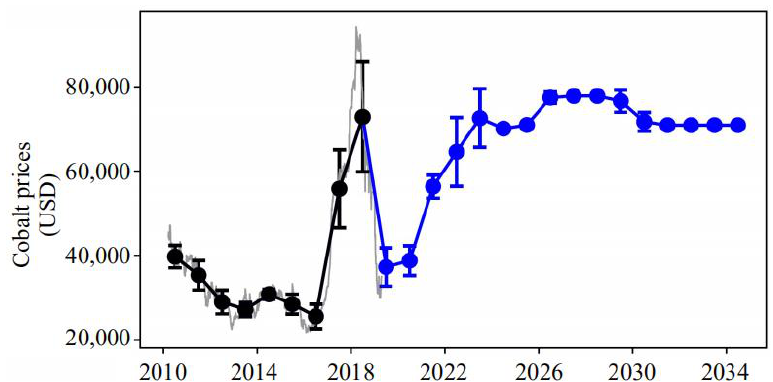
Figure 7. Forecast results of cobalt price in the next 16 years.